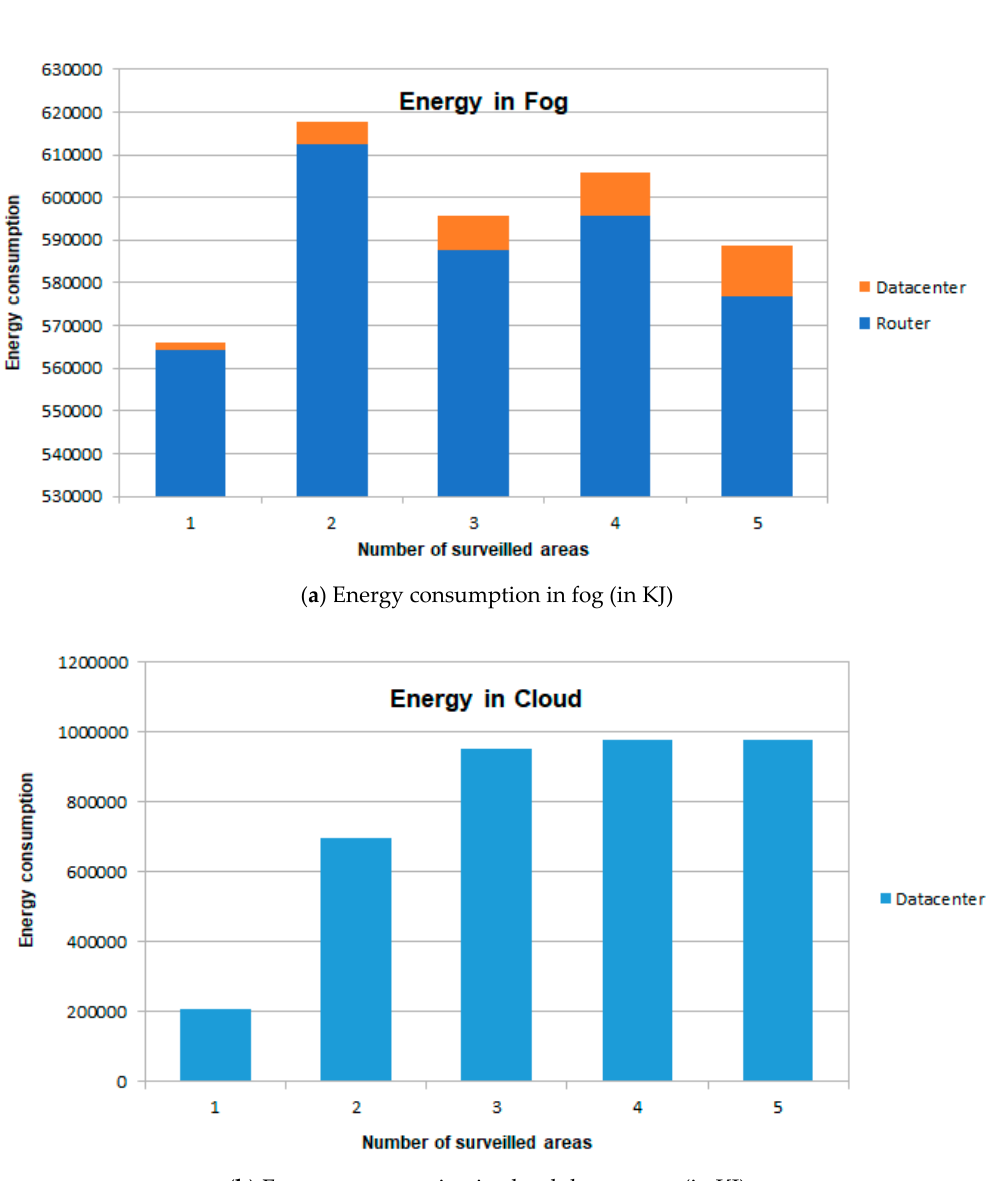
Figure 4. Energy consumption in fog and cloud platforms (in KJ).